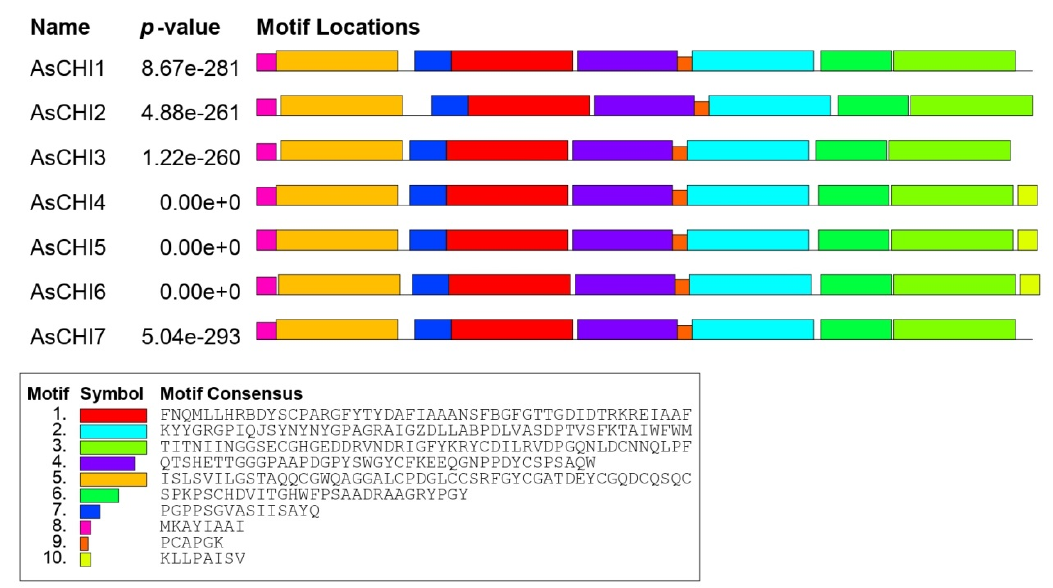
Figure 2. Distribution of conserved motifs in AsCHI proteins of A. sativum cv. Ershuizao. Analysis was performed using Multiple Em for Motif Elicitation (MEME) 5.3.0. The length of each box corresponds to that of the motif.